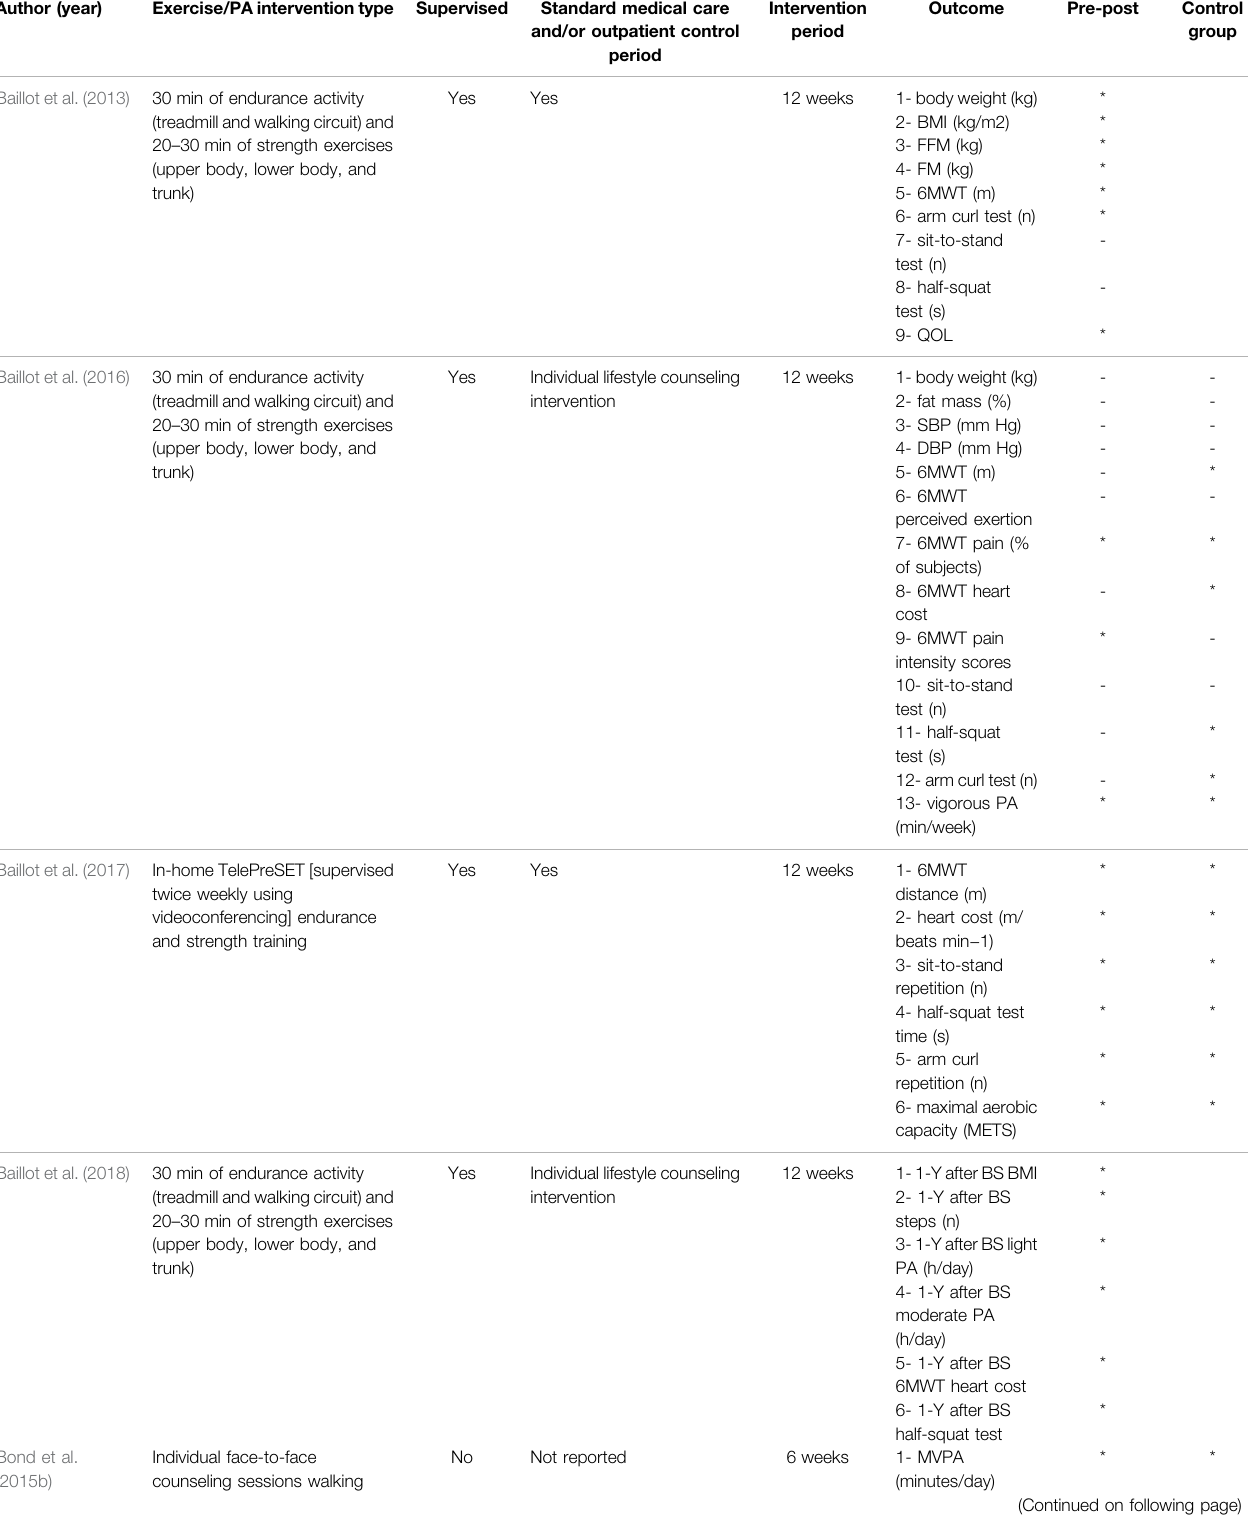
Intervention Outcome Pre-post Control and/or outpatient control period group period